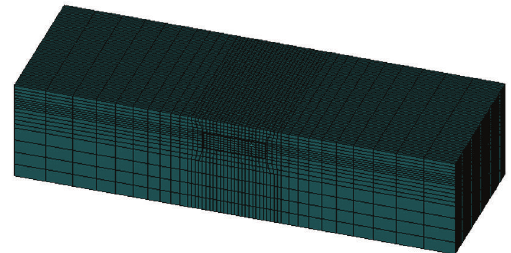
Figure 7: Tunnel finite element